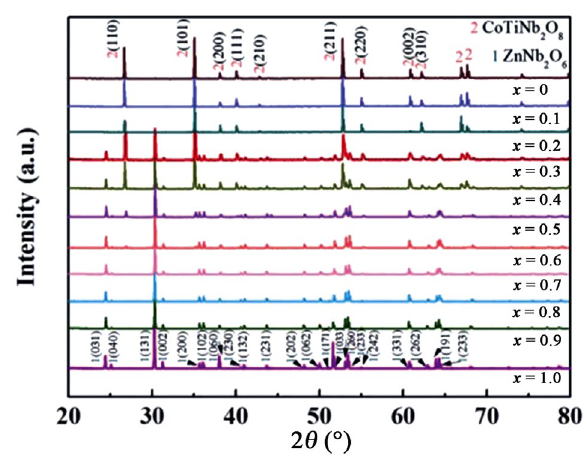
Fig. 1 XRD patterns of (1 − x )CoTiNb 2 O 8 − x ZnNb 2 O 6 ceramics sintered at the optimum sintering temperature.